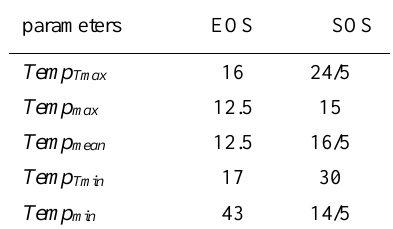
Table 2: Percentage of pixels with best linear regression with phenological parameters (EOS and SOS) as the dependent variable and the temperature parameters (Temp Tmax , Tempmax,